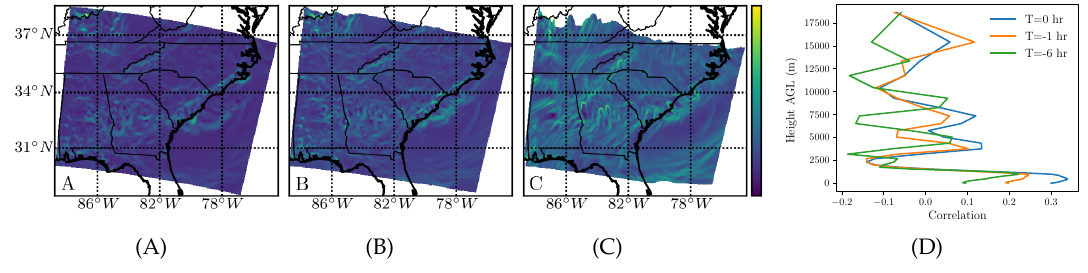
Figure 8. The same as in Figure 4, but for nitrogen dioxide (NO 2